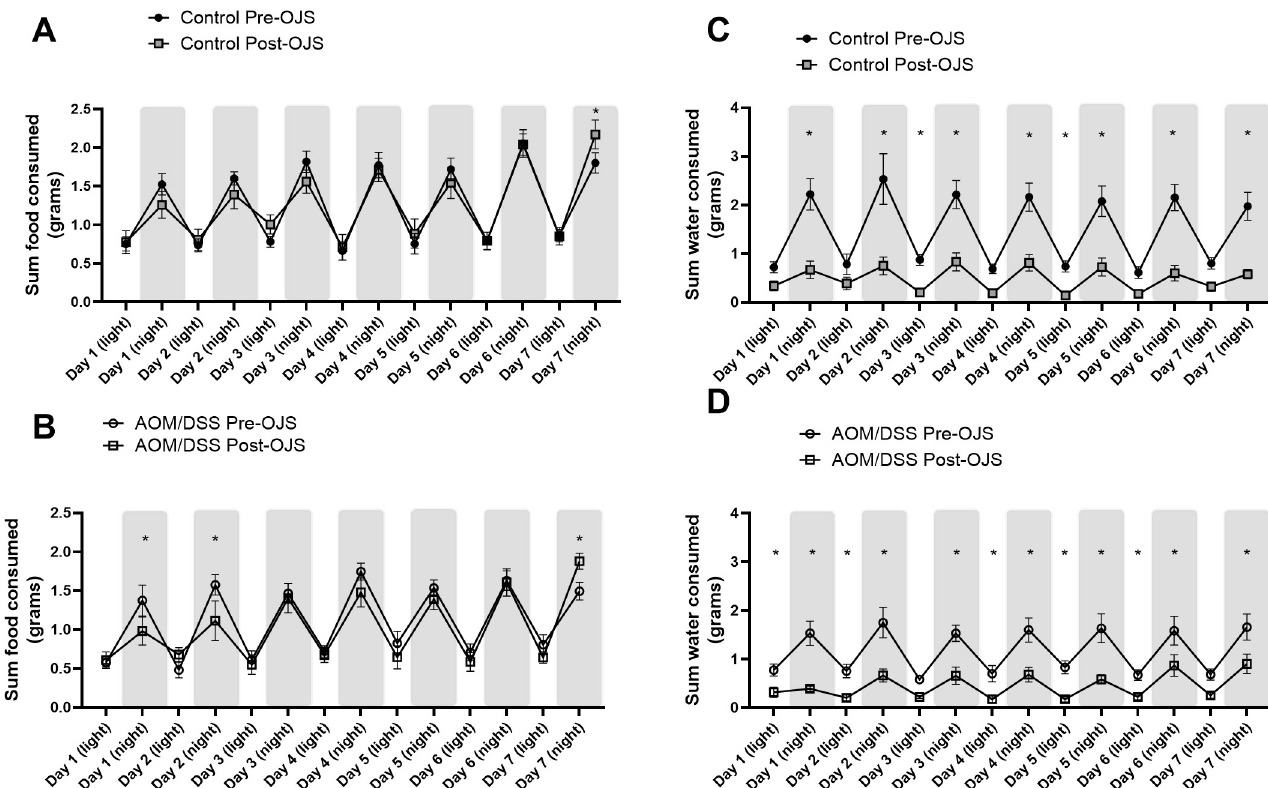
Fig 8. Mice decreased water intake when OJS was added to the water bottle. Food (A, B) and water (C, D) intake in grams during the light and night cycle for control (non-cancer) and AOM/DSS mice. � Indicates statistical significance between groups (p < 0.05) from two-way RM ANOVA Fisher LSD, n = 8, control, and n = 8